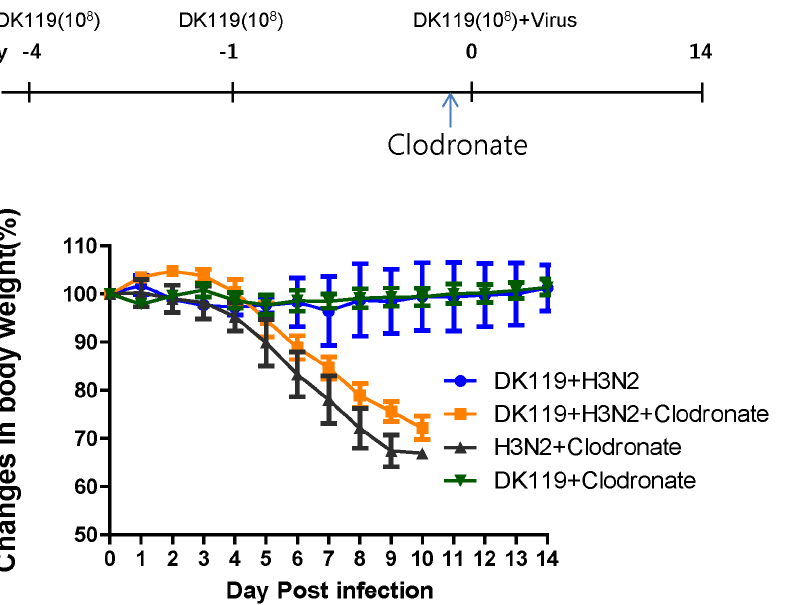
Figure 12. Effects of clodronate treatment on DK119-mediated protection against H3N2 influenza virus infection. Groups of mice (n=6) were two times treated with DK119 (10 8 CFU/mouse) at 4 and 1 day earlier, then either received clodronate or PBS 4 hours prior to infection with A/Philippines/82H3N2 virus (2.5 LD 50 ) in the presence of a low dose of DK119 (10 8 CFU per mouse). DK119 + H3N2: mice pretreated with DK119 were infected with A/Philippines/82 (H3N2) virus. DK119 + clodronate + H3N2: mice pretreated with DK119 were intranasally administered clodronate prior to infection with A/Philippines/82 (H3N2) virus. H3N2 + Clodronate: mice treated with clodronate 4 hours prior to infection.DK119 + Clodronate: mice treated with DK119 at the same doses and then clodronate administration. Bars indicate standard